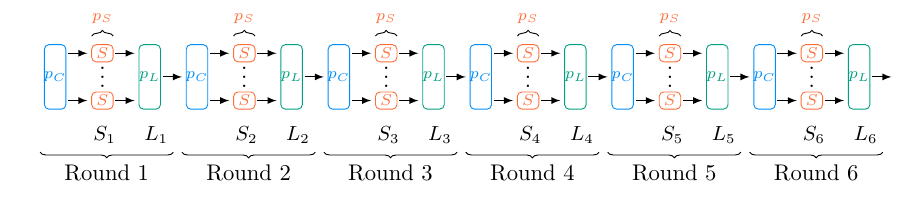
Figure 4: The iterated permutation p 6 .